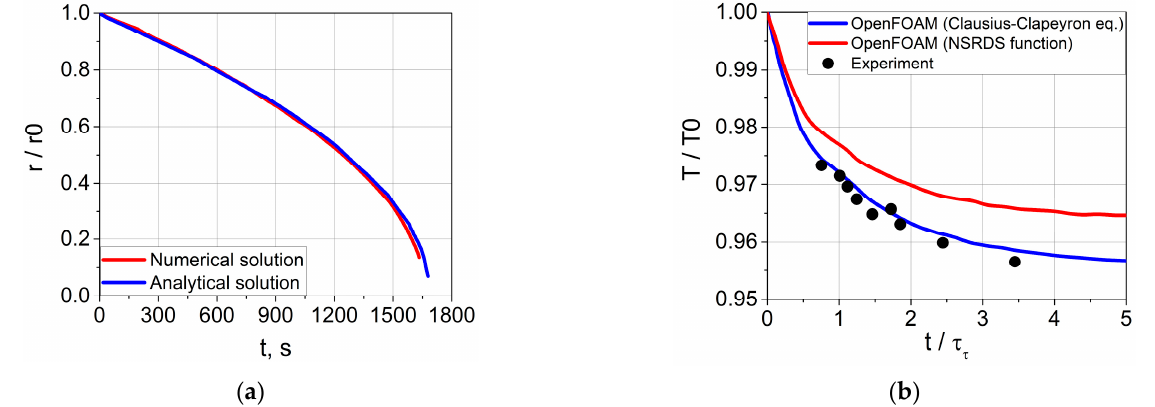
Figure 2. Drop evaporation tests: ( a ) particle size dependence over time; ( b ) temperature dependence over time.